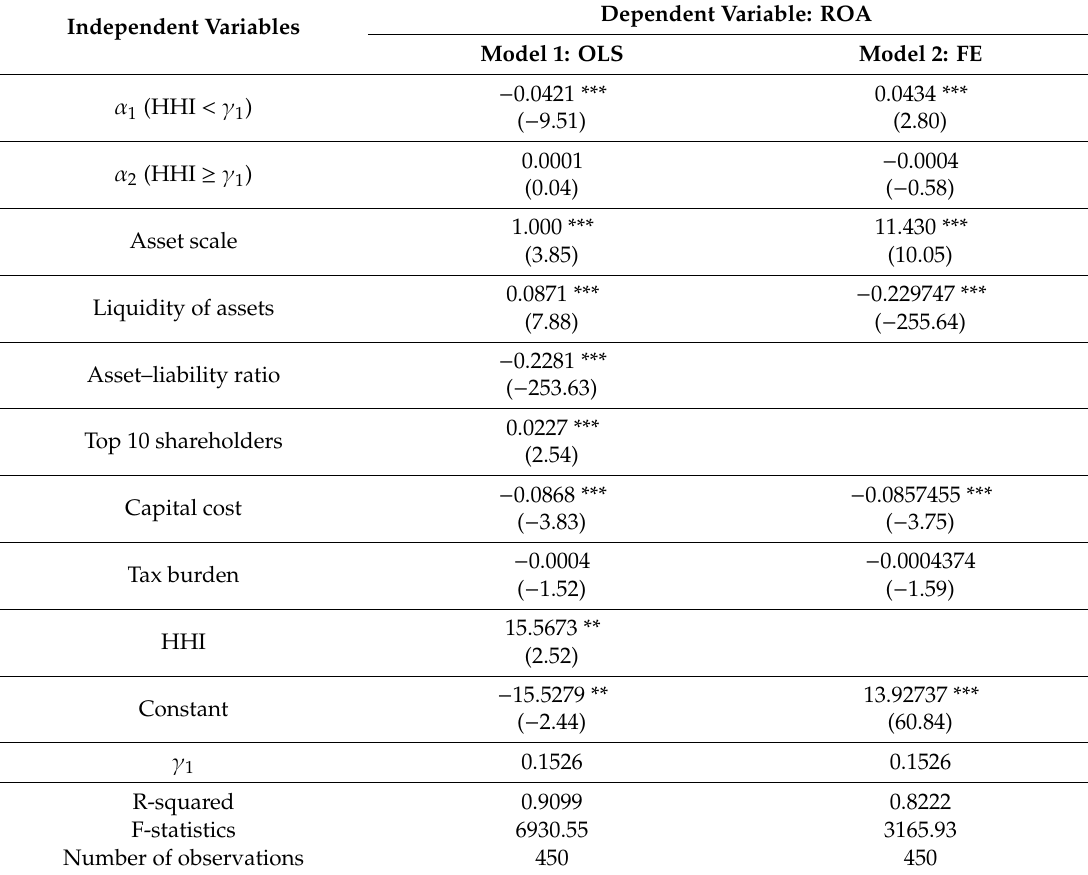
Table 5. Threshold regression of labor cost impact on financial